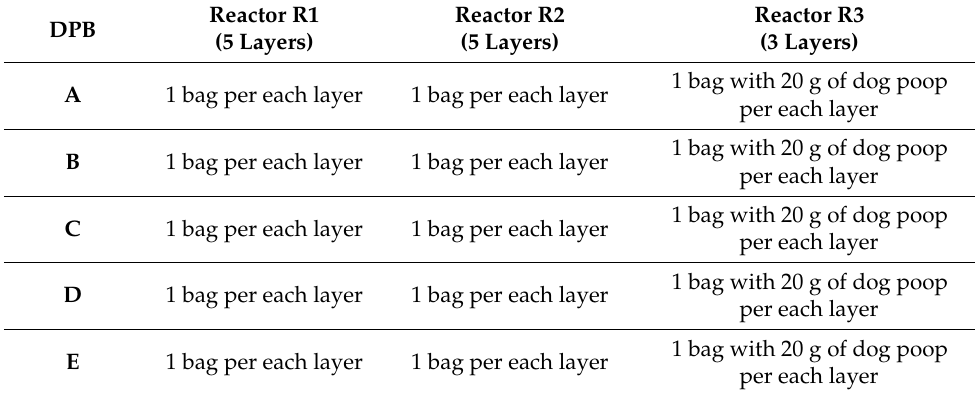
Table 3. The arrangement of the investigated DPBs in the composting reactors.